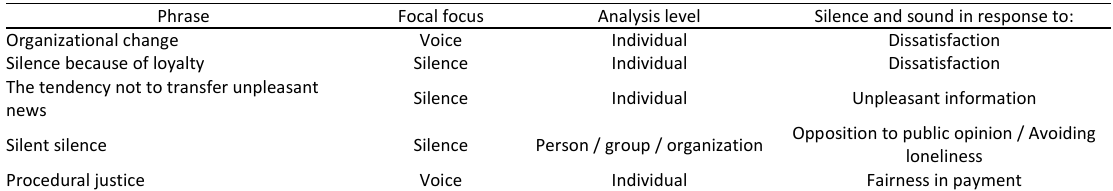
Table 1. The first wave of evolution of organizational silence (Edwards et al ., 2009 ) Table 1: The first wave of evolution of organizational silence (Edwards